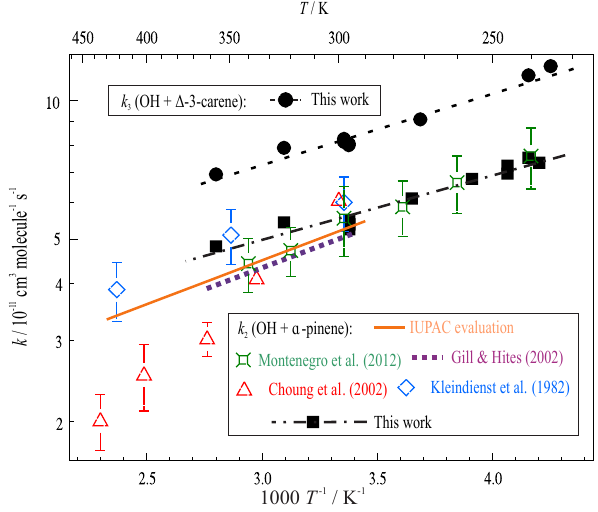
Figure 9. k 2 (T ) and k 3 (T ) from this work in Arrhenius format, together with previous experimental results and a k 2 (T ) literature evaluation. Data from this work were fit with (Eq. 4) to yield k 2 (238–357K) = ( 1 . 83 ± 0 . 04 ) × exp { ( 330 ± 6 )/T } (represented by the black dot-dashed line) and k 3 (235–357K) = ( 2 . 48 ± 0 . 14 ) × exp { ( 357 ± 17 )/T } (the black dashed line). Not displayed for rea- sons of clarity are literature datasets containing only ambient tem- perature k 2 results (these are listed in full in Table 3) and the 44 de- terminations of k 2 (297–364K) from Gill and Hites (2002), which are instead represented (purple dotted line) by a fit with (Eq.